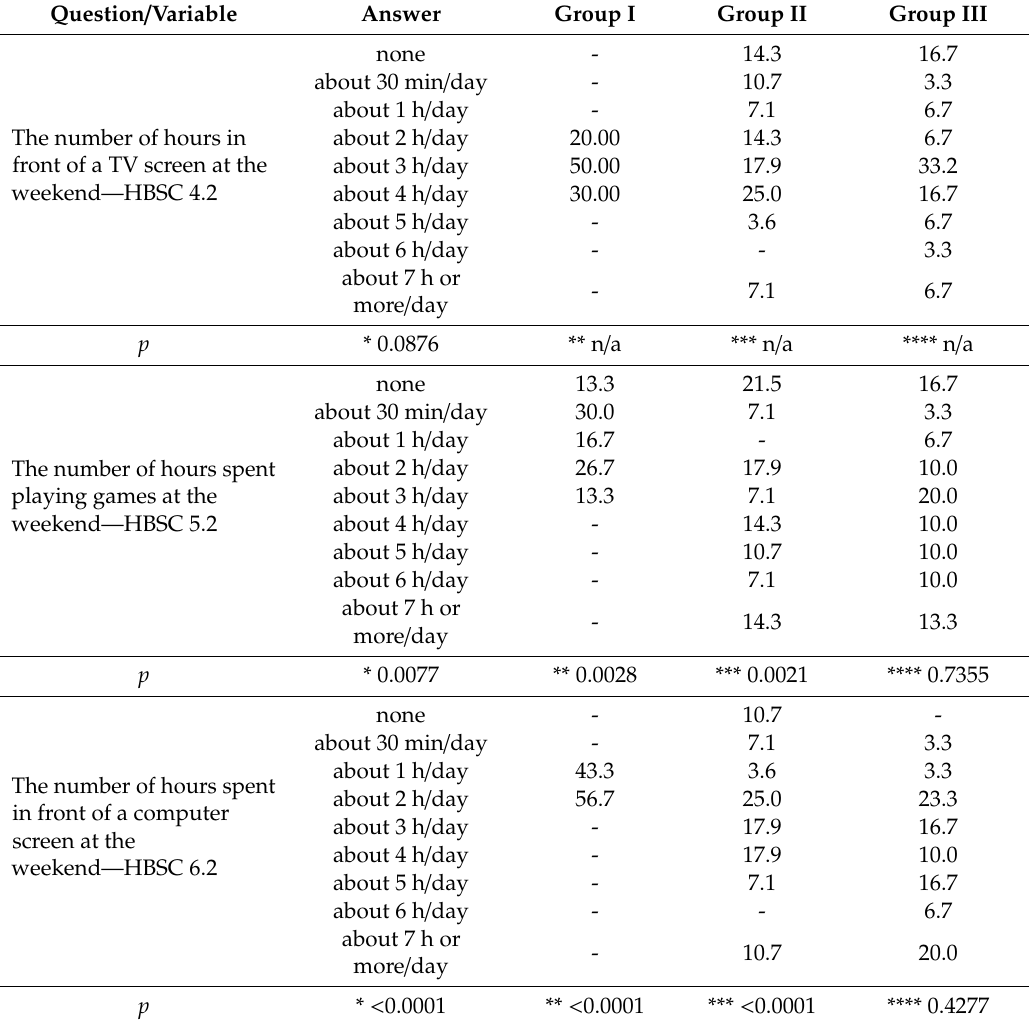
Table 5. Time spent in front of a computer / TV screen on o ff -days. The percentage of respondents providing a given answer